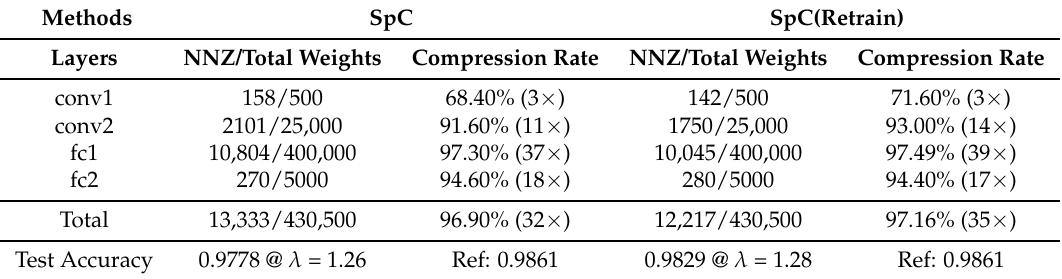
Table A1. Layer-wise compression of lenet-5 (MNIST dataset). NNZ stands for number of non-zeros.